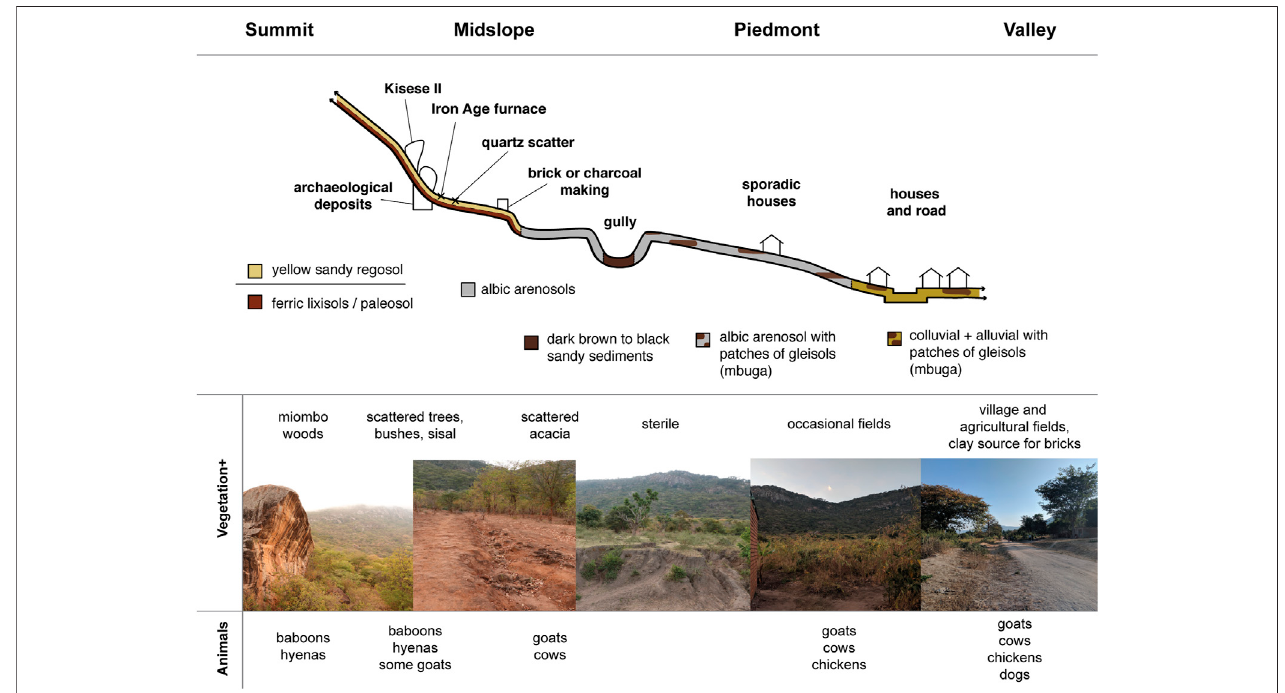
FIGURE 2 | Schematic diagram representing the transect of the slope where Kisese II is located. The elevation of the site is 1,287 ± 3 m above sea level. The diagram shows a geoarchaeological catena constructed from the results of ourfoot survey.To create aresource relevantto archaeologicalwork wecombineda classic soil catena with environmental features such as vegetation and fauna, and anthropogenic features such as sites and modern human presence. Follows a description of the soils we recorded on the slope ( Table 1 ).